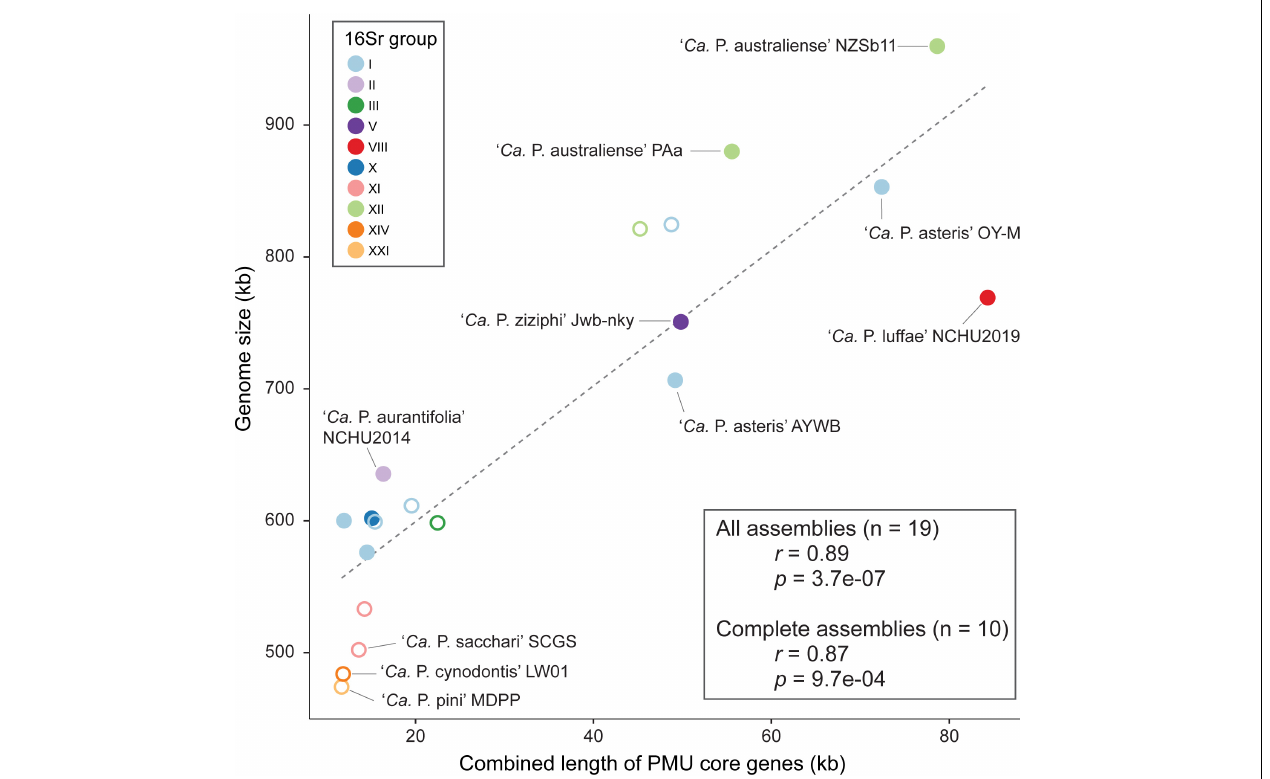
FIGURE 7 | Correlation between the combined length of PMU core genes and genome size. Strains with complete and draft genome assemblies are indicated by filled and open circles, respectively. The linear regression line was based on all available